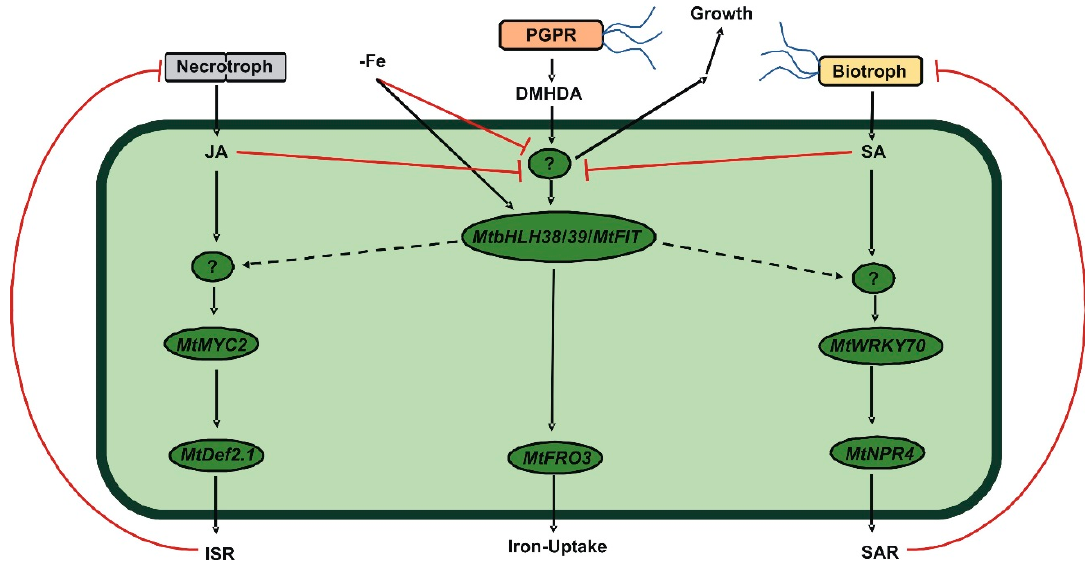
Figure 11. Proposed model of cross-talk between systemic acquired resistance (SAR), induced systemic resistance (ISR), and iron-deprivation response pathways mediated by N,N-dimethylhexadecylamine (DMHDA) in Medicago truncatula . Necrotrophic pathogens trigger jasmonic acid (JA) synthesis in plant cells, which downstream induces the expression of MtMYC2 and MtDef2.1 as ISR responses, which in turn inhibit the necrotrophic pathogen attack. Biotrophic pathogens trigger salicylic acid (SA) synthesis in plant cells, which downstream induces the expression of MtWRKY70 and MtPR4 as SAR responses, which in turn inhibit the biotrophic pathogen attack. Some plant growth promoting rhizobacteria (PGPR) produce DMHDA that activates a regulatory element upstream of MtbHLH38 / 39 / MtFIT that induces MtFRO3 as an iron-deprivation response. This regulatory element also promotes plant growth. Iron deprivation induces MtbHlH38 / 39 / MtFIT but inhibits plant growth, probably through a regulatory element located upstream of MtbHlH38 / 39 / MtFIT . JA and SA inhibit plant growth and iron-deprivation responses upstream of MtbHlH38 / 39 / MtFIT. MtbHlH38 / 39 / MtFIT induces ISR upstream of MtMYC2 and SAR upstream of MtPR4.